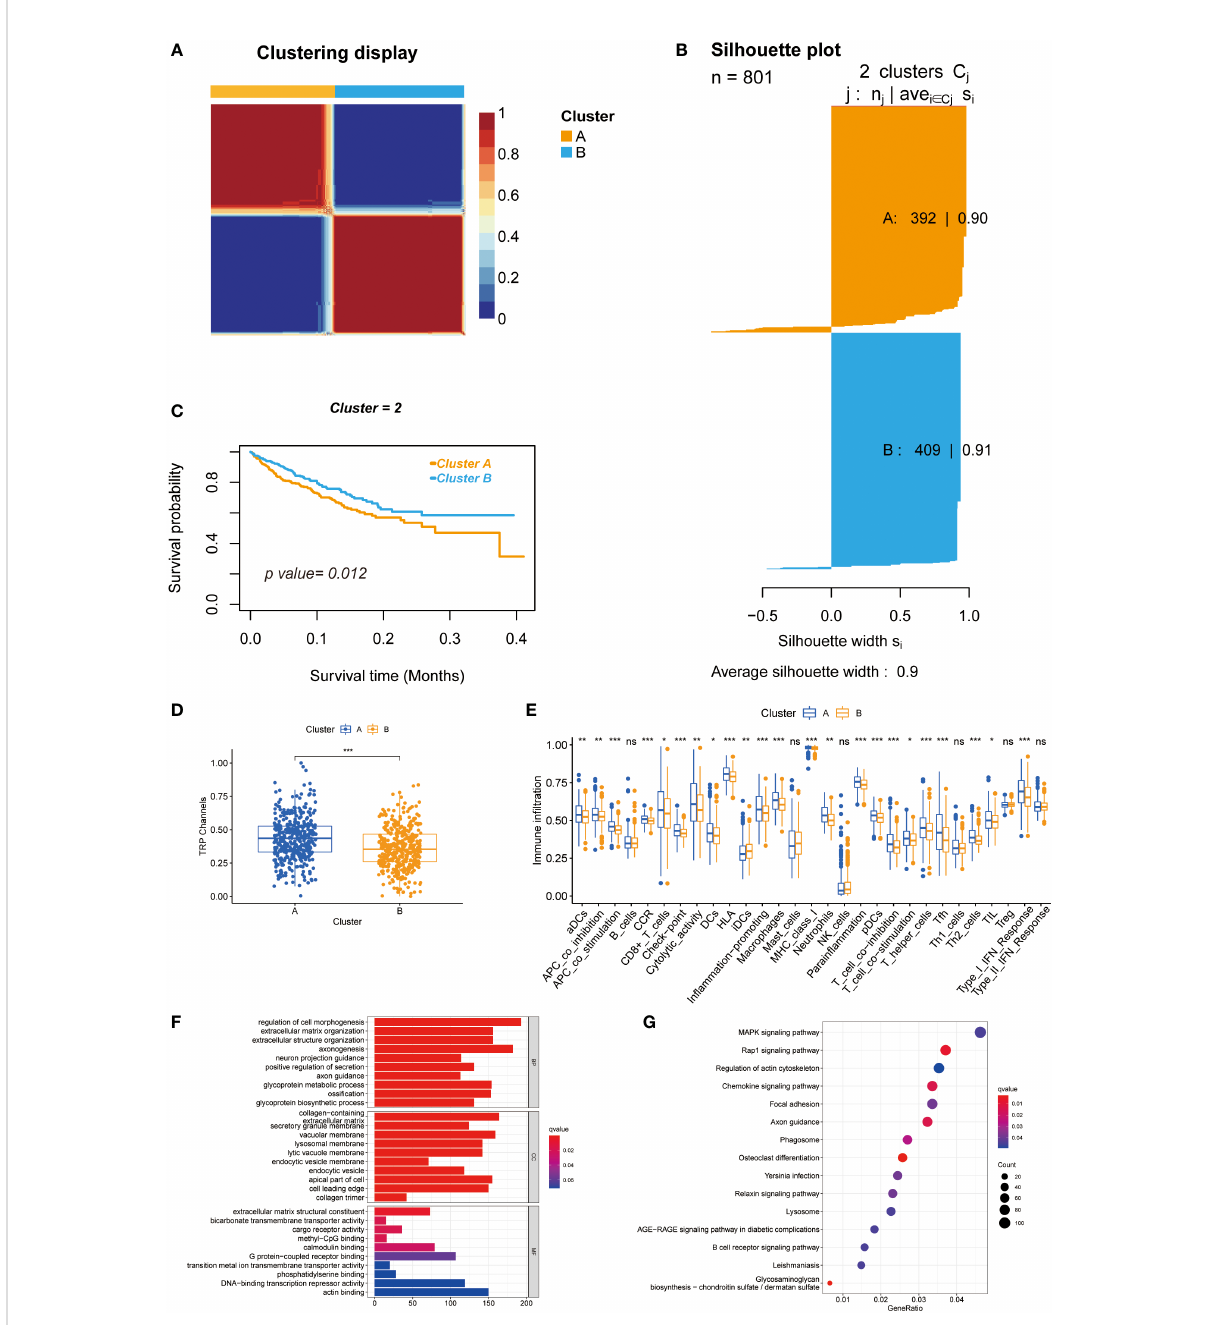
FIGURE 2 Unsupervised clustering of 28 TRPCR and differences between two clusters. (A) Heatmap representation of NMF clustering for TRPCR. (B) Kaplan-Meier curves of OS with two TRPC clusters. (C) Silhouette plot of the two clusters. (D) The TRPC activity between two clusters. (E) The ssGSEA scores of immune cells and immune-related functions with two clusters. (F, G) Functional annotation for TRPC clusters using GO and KEGG enrichment analysis. GO, Gene Ontology; KEGG, Kyoto Encyclopedia of Genes and Genomes; OS, overall survival; ssGSEA, single sample gene set enrichment analysis; TRPC, transient receptor potential channels; TRPCR, transient receptor potential channels regulators; ns, not signi fi cant; *P< 0.05; **P< 0.01; ***P<